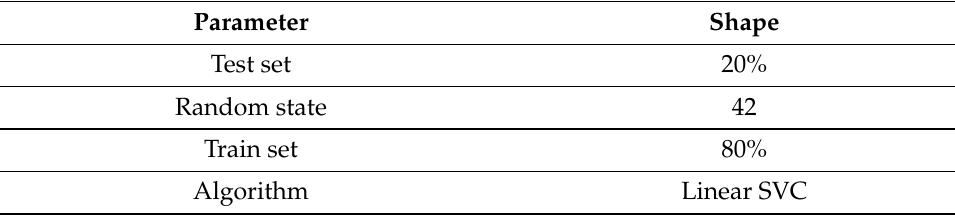
Table 5. The Specification of the SVM.